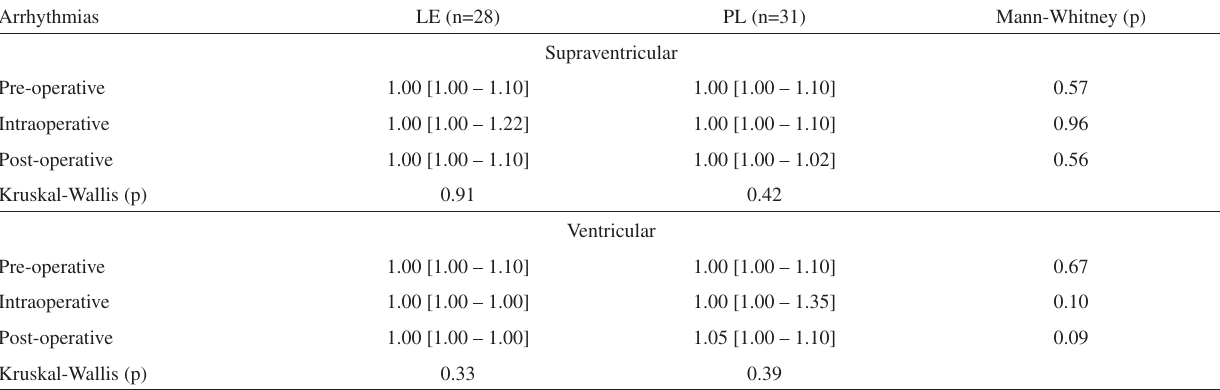
Table 3 - Number of irregular complexes during dental treatment periods in the PL and LE groups (median [25%-75%])